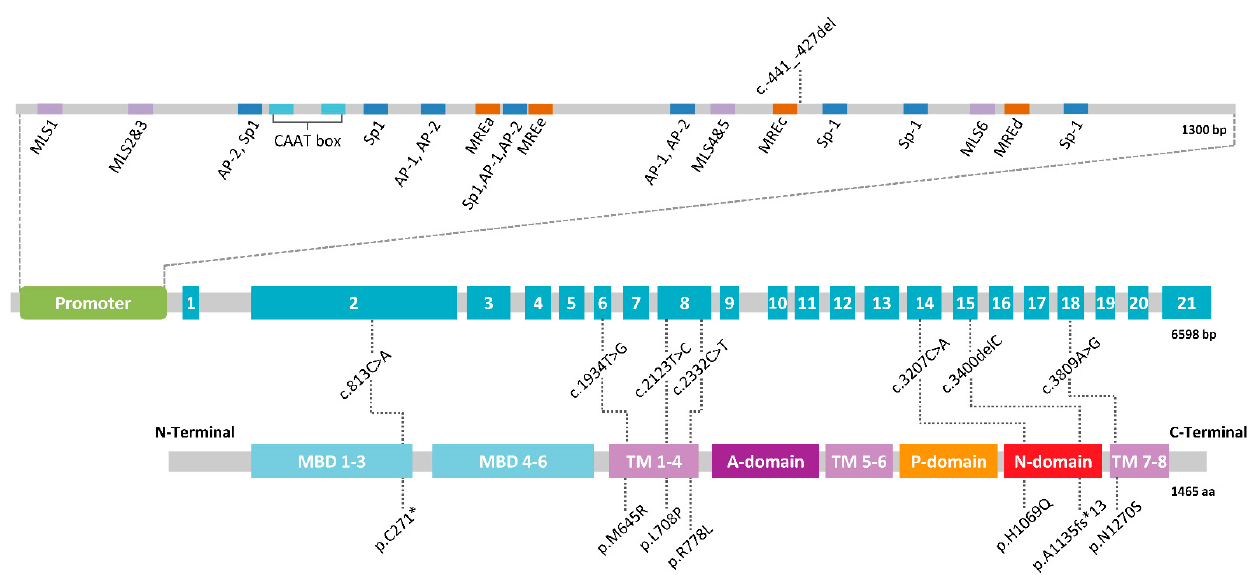
Figure 2. Scheme of the ATP7B gene with common mutations. For the promoter region, most relevant elements and transcription factor binding sites are depicted, as described in Oh et al. [69]. Abbreviations: MRE, metal response element; MLS, MRE-like sequence; MBD, metal binding domain; TM, transmembrane domain; A-domain, actuator domain; P-domain, phosphorylation domain; N-domain, nucleotide binding domain; aa, amino acids; bp, base pairs.